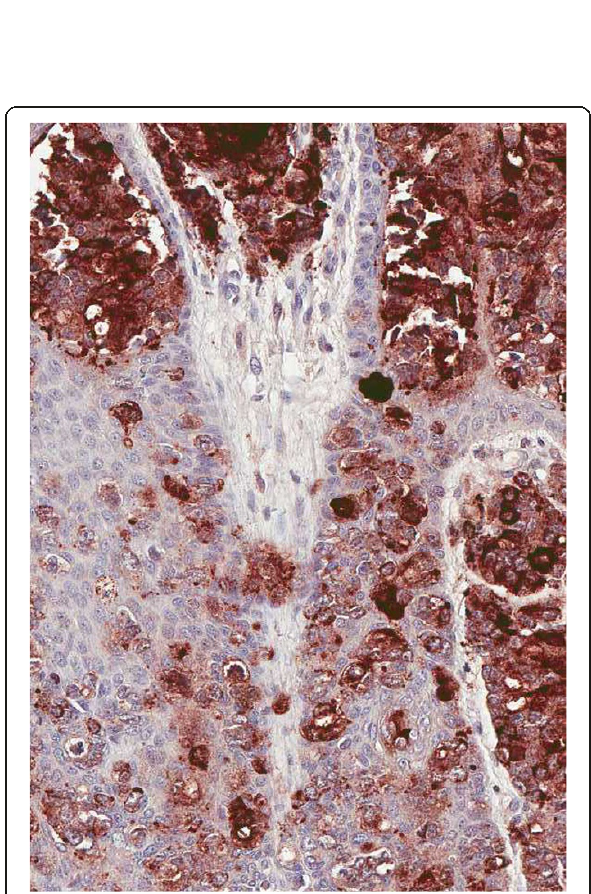
Figure 7 Dermal and epidermal PSAP positivity, high